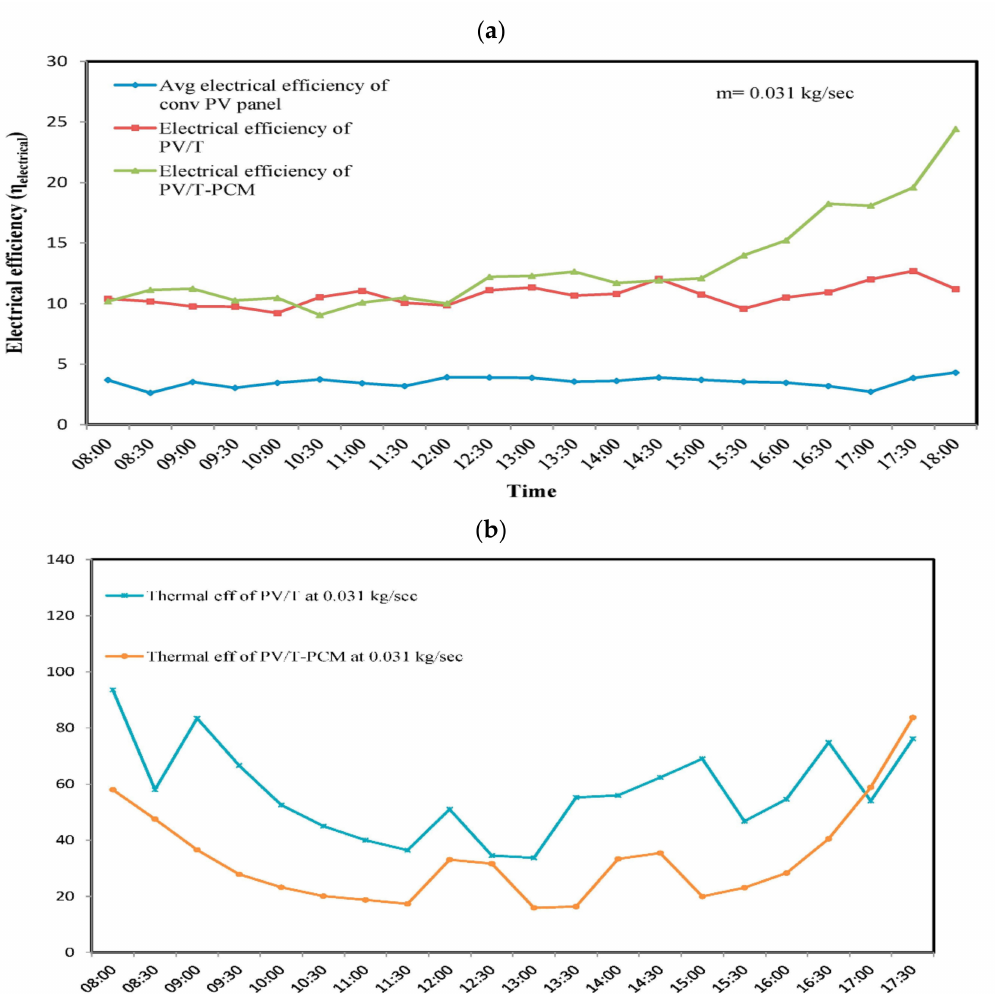
Figure 23. ( a ) Electrical efficiency at 0.031 kg/s; ( b ) thermal efficiency at 0.031 kg/s (reprinted from [116], with permission from